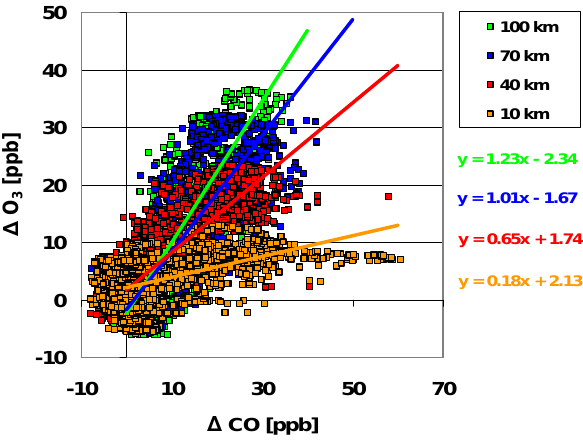
Fig. 7. 1 O 3 to 1 CO enhancement factors as a function of down- wind distance from Manaus City during Flight #18 on 19 July 2001, 10:00–14:00LT. Data from all transects of each vertical profile are binned. Slopes of a linear regression using the reduced-major-axis (RMA) regression method are